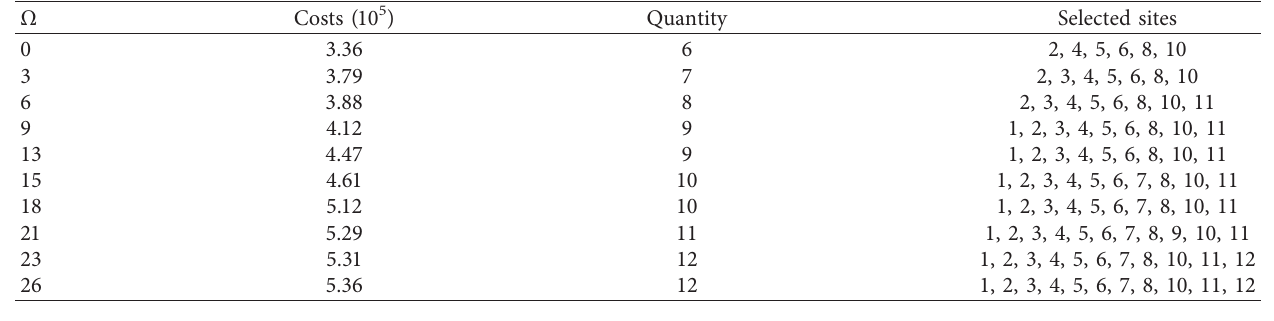
Table 9: Optimal scheme under MIRP-ellipsoid set.